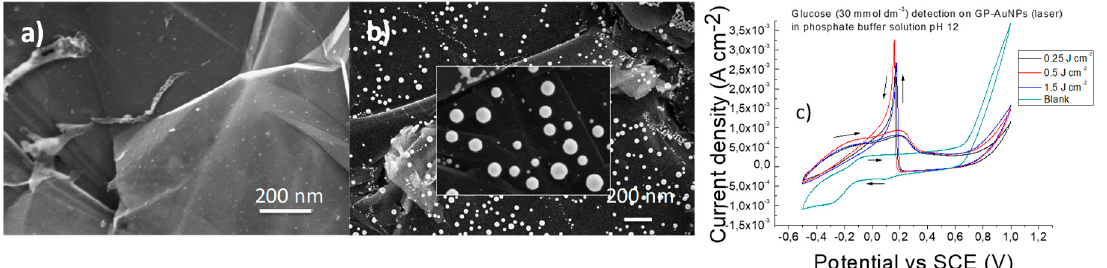
Figure 1. Representative SEM pictures of: ( a ) graphene paper after laser irradiation at fluence of 0.5 J cm − 2 ; ( b ) Au layer 8 nm thick after laser annealing at fluence of 0.5 J cm − 2 ; ( c ) voltammograms of glucose 30 mmol dm − 3 at pH 12 buffer solution detected with GP-AuNPs electrodes laser annealed at 0.25, 0.5 and 1.5 J cm − 2